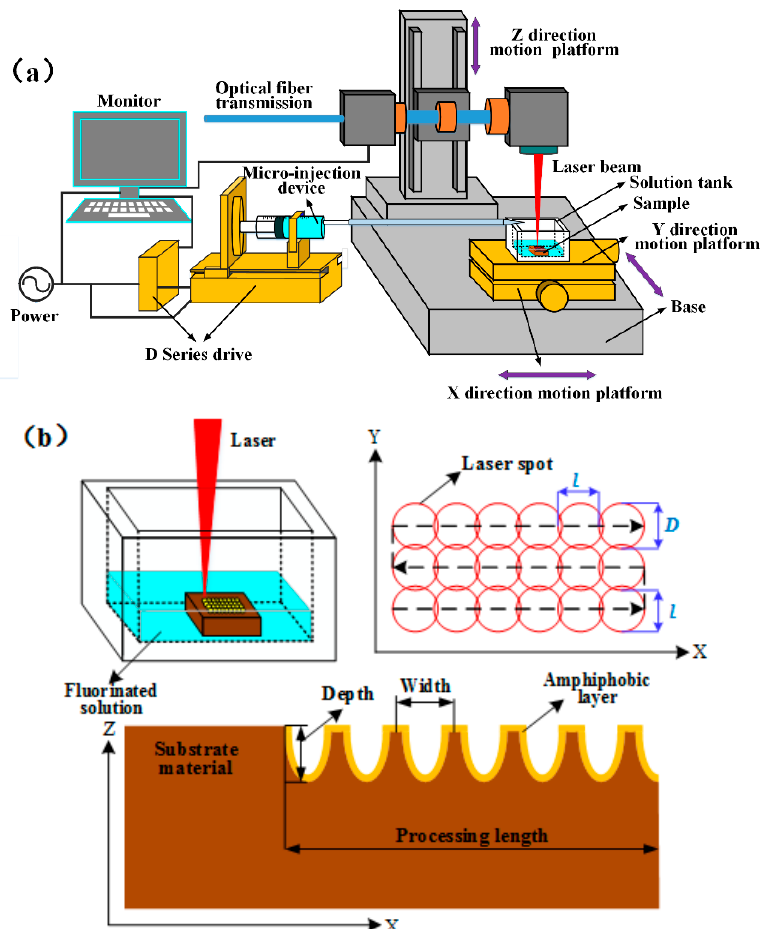
Figure 1. ( a ) Schematic representation of the processing platform; ( b ) schematic representation of the machining process.